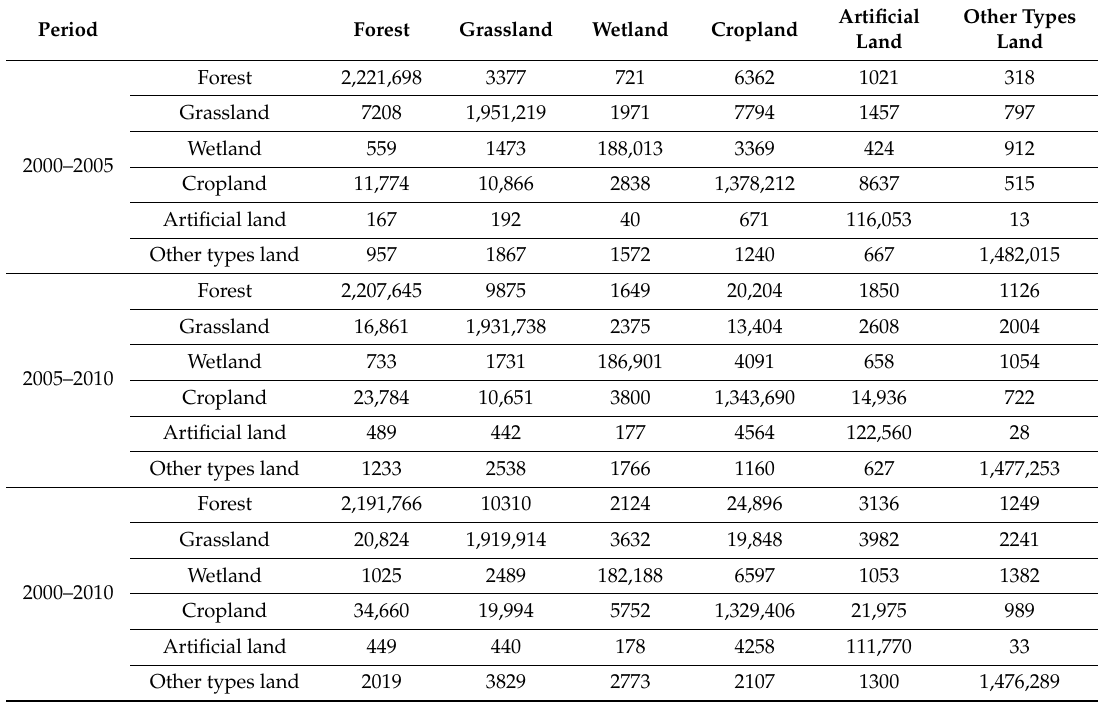
Table 4. LULC transfer matrix of the Grain for Green Program (GGP) area from 2000–2010 (km 2